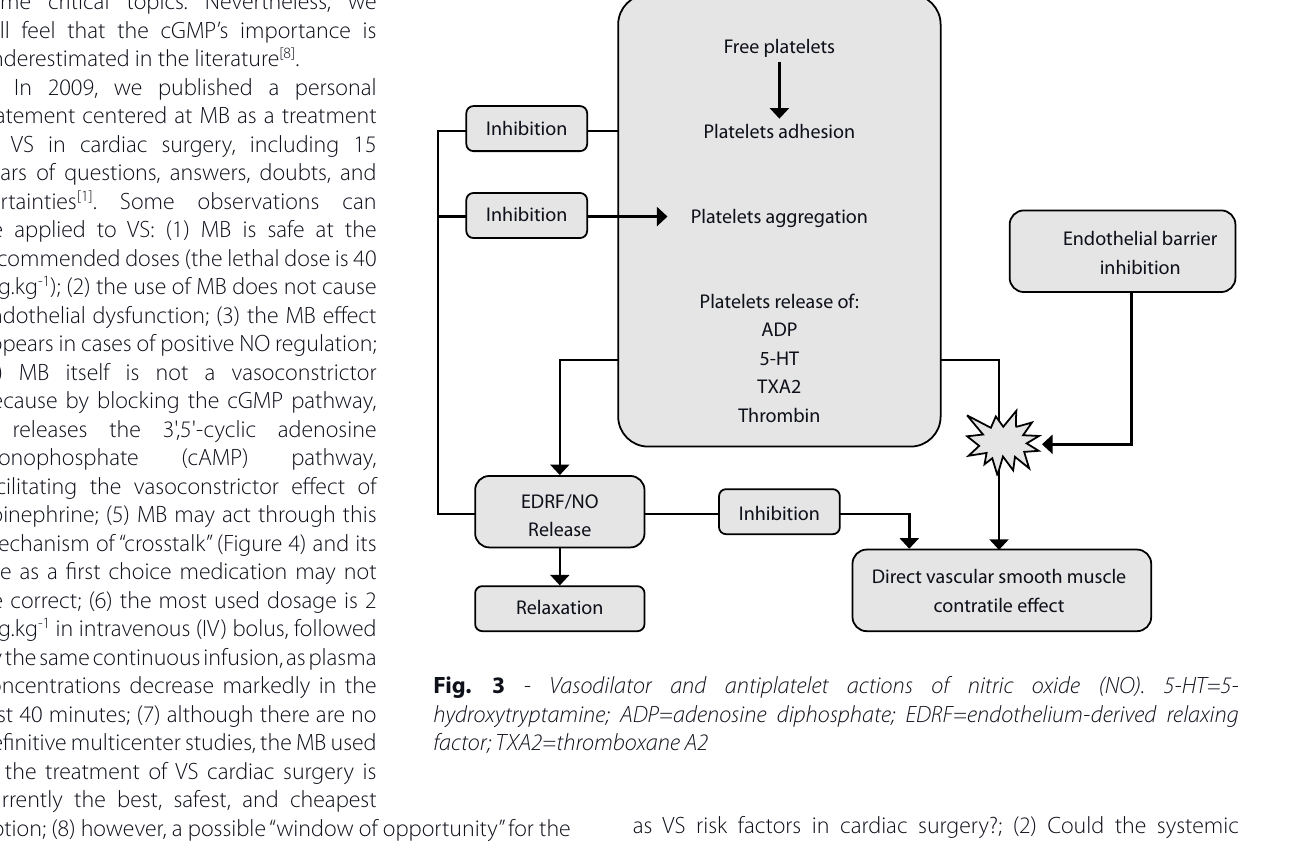
Table 1 . Classification of endothelial dysfunction.